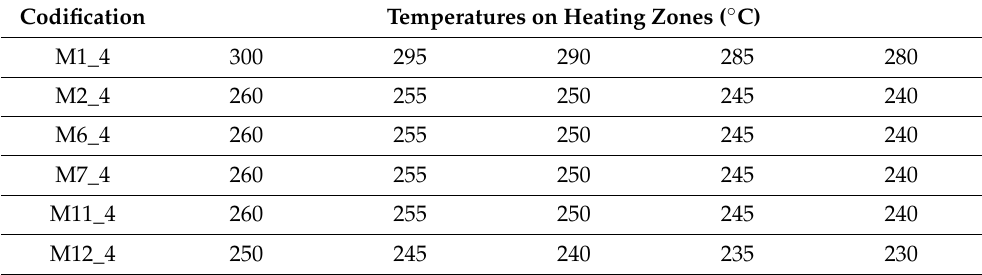
Table 1. Processing temperature